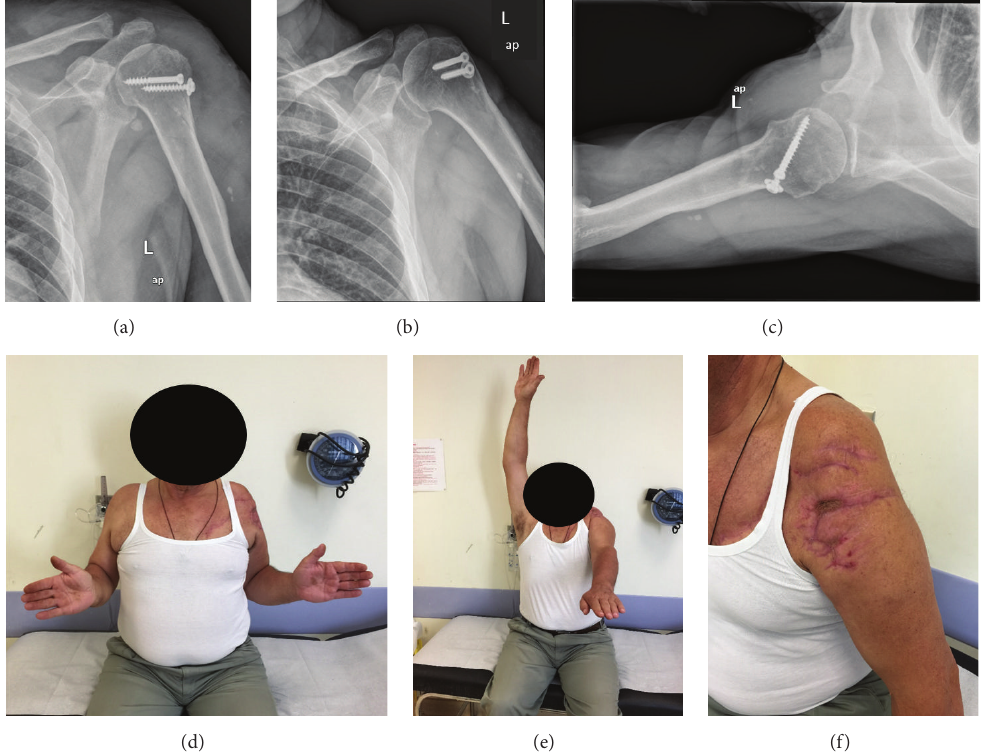
Figure 2: ((a)–(c)) Radiological examination at 12 months with anteroposterior views in external (a) and internal (b) rotation as well as axillary view of the shoulder (c) indicated solid union of the fracture. ((d)-(e)) Poor clinical outcome especially in forward elevation due to axillary nerve neurapraxia. (f) Clinical picture of the wound at 17 months after